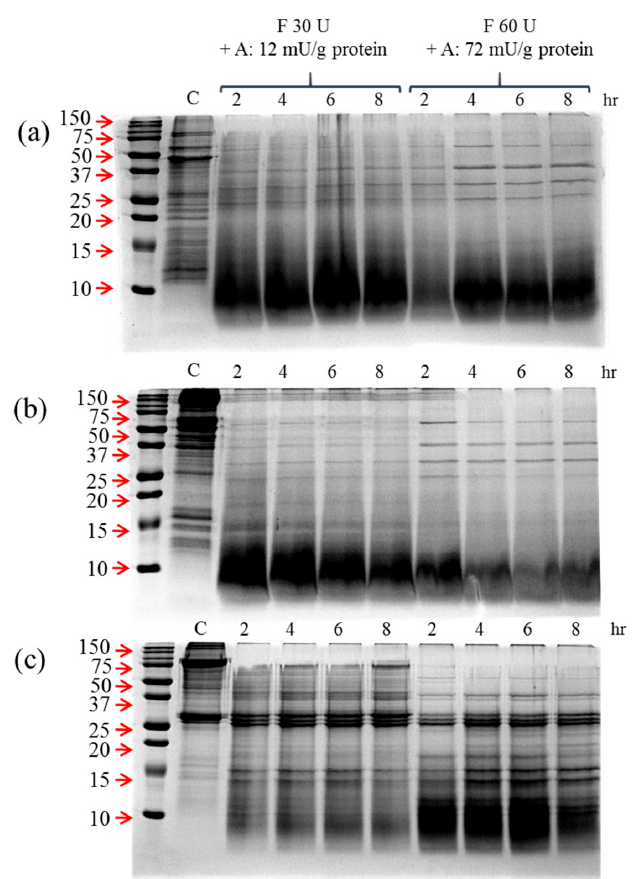
Figure 2. Hydrolysis pattern of ( a ) mealworm, ( b ) cricket, and ( c ) silkworm pupae protein extracts through using Flavourzyme and Alcalase enzyme mixtures. Two different doses of enzymes were applied. Left: Flavourzyme: 30 U + Alcalase: 12 mU/g protein. Right: Flavourzyme: 60 U + Alcalase: 72 mU/g protein. The numbers above the lanes signify the treatment times in hours.